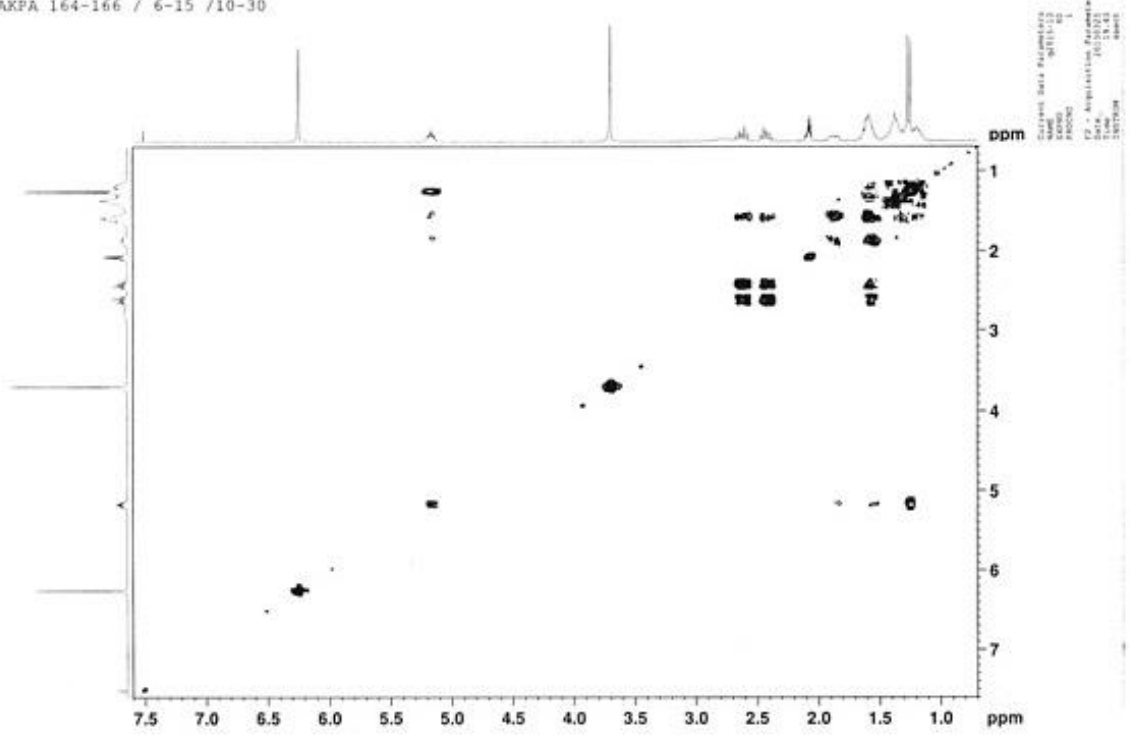
Figure A7. COSY spectrum of isolated